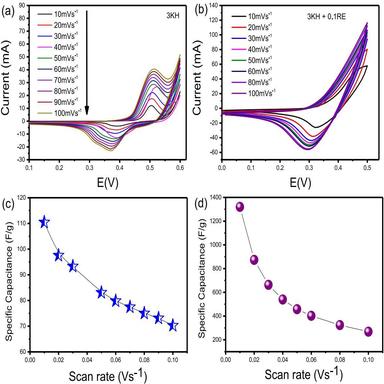
Cyclic voltammetry curves of LBG-cl-PAN- IONP in (a) 3 KH and (b) 3 KH+0.1RE at different scanning rates (10–100 mV s − 1 ). (c) Plots of specific capacitance versus potential scan rate in 3 KH; (d) Plots of specific capacitance versus potential scan rate in 3 KH+0.1RE.